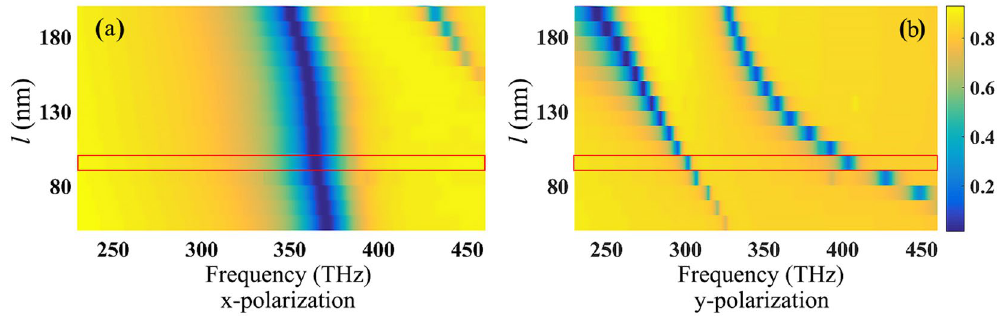
Figure 3. Transmission spectrum with different length of l 1 in Fig. 1(c). The responses shows an obvious relationship with polarization. The dimensions in red line was selected in our simulation work due to the proper positions of resonance